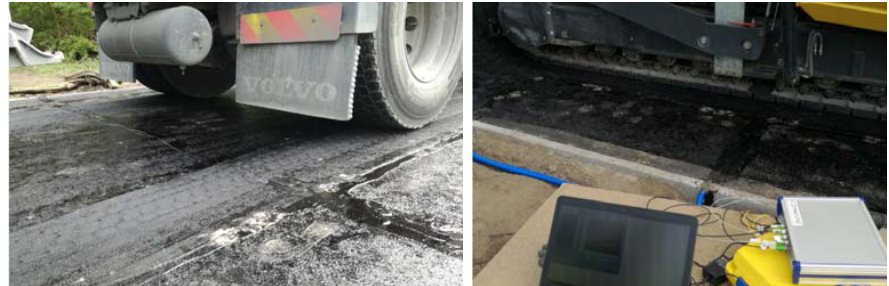
Figure 10. Monitoring of FBGs on the third day during the construction of top layer of the CyPaTs bicycle path at a temperature of 24 °C on the surface of the second base layer AC-10.